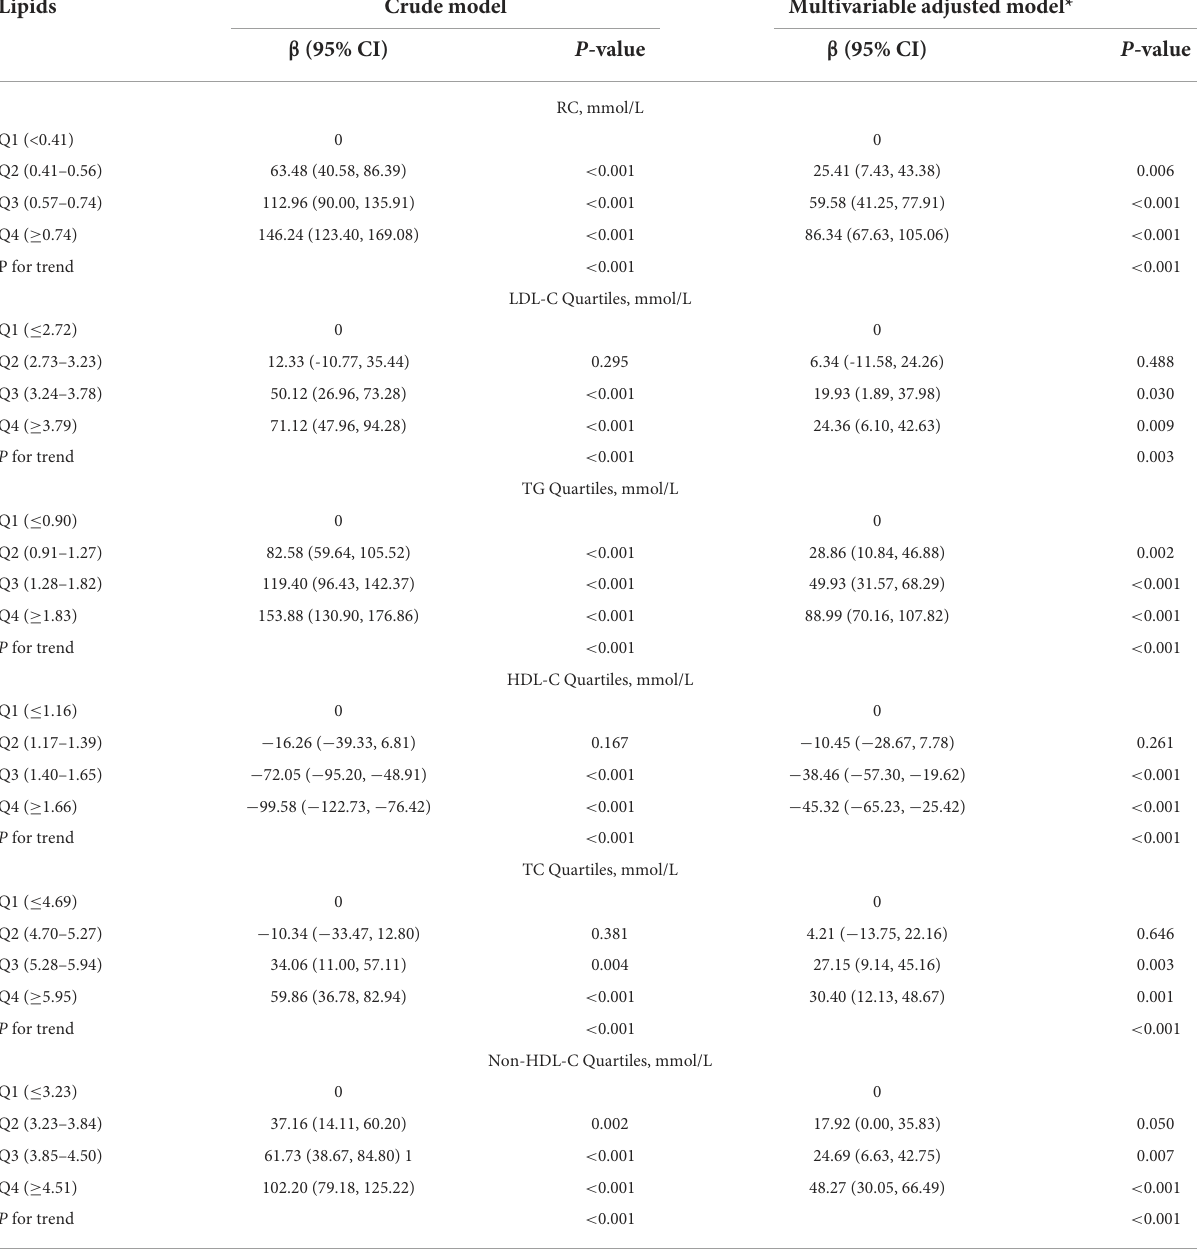
TABLE 2 Associations between brachial-ankle pulse wave velocity and each lipid index. Lipids Crude